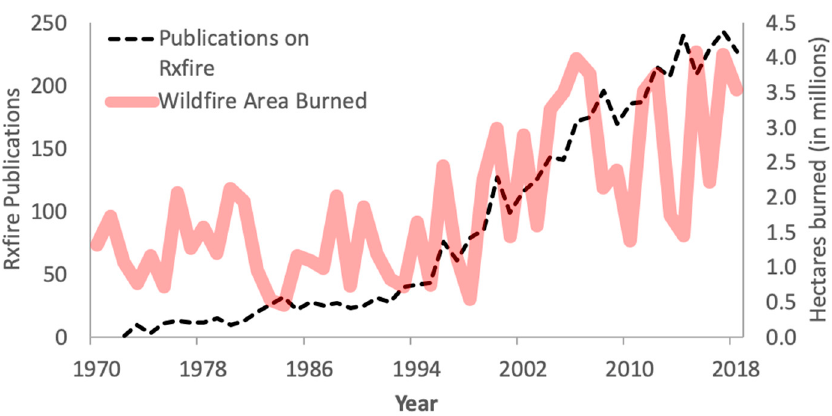
Figure 1. Annual publications on prescribed fire (dashed black line) and annual area burned (red solid line) for the United States (US), 1970 to 2018.